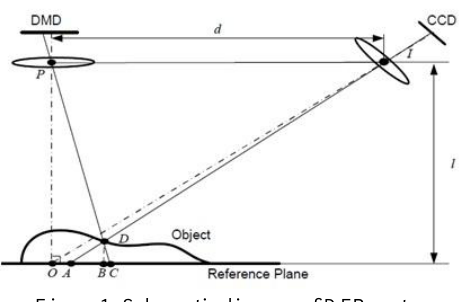
Figure 1. Schematic diagram of DFP